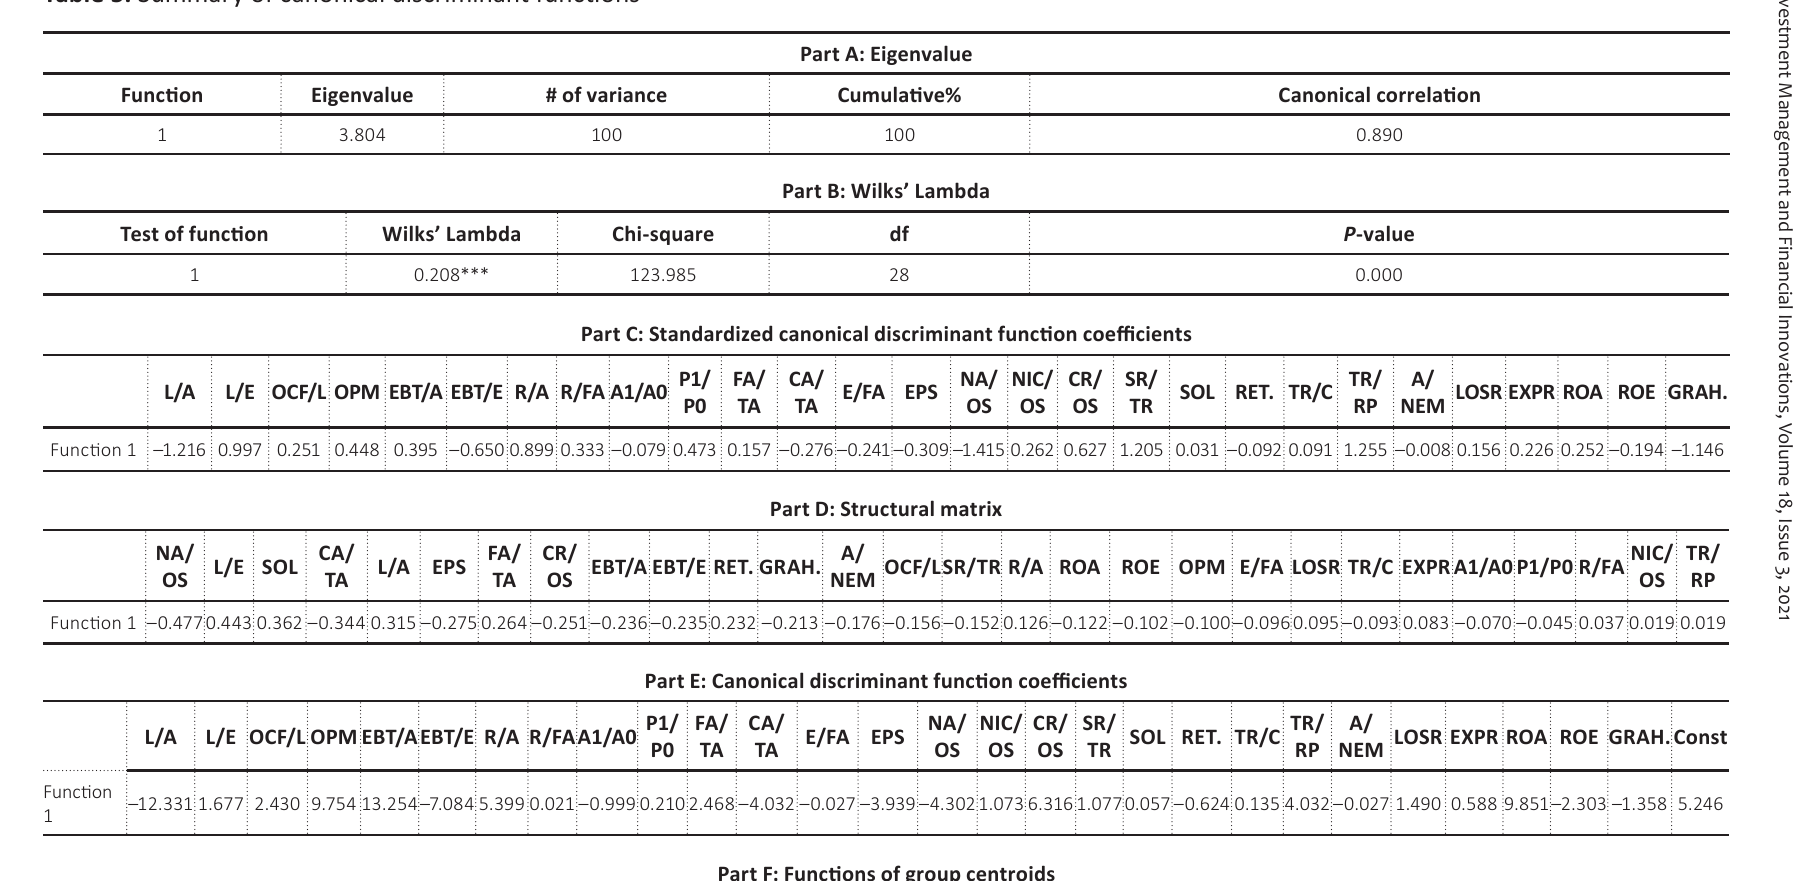
Table 5. Summary of canonical discriminant